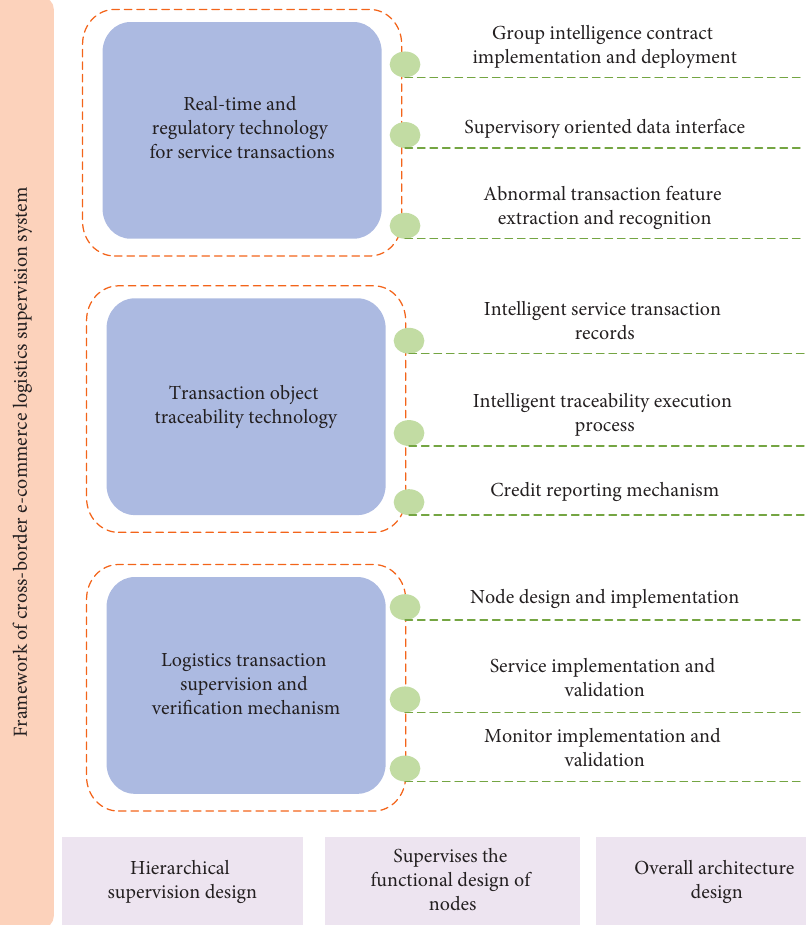
Figure 5: Software framework of cross-border e-commerce logistics supervision system.